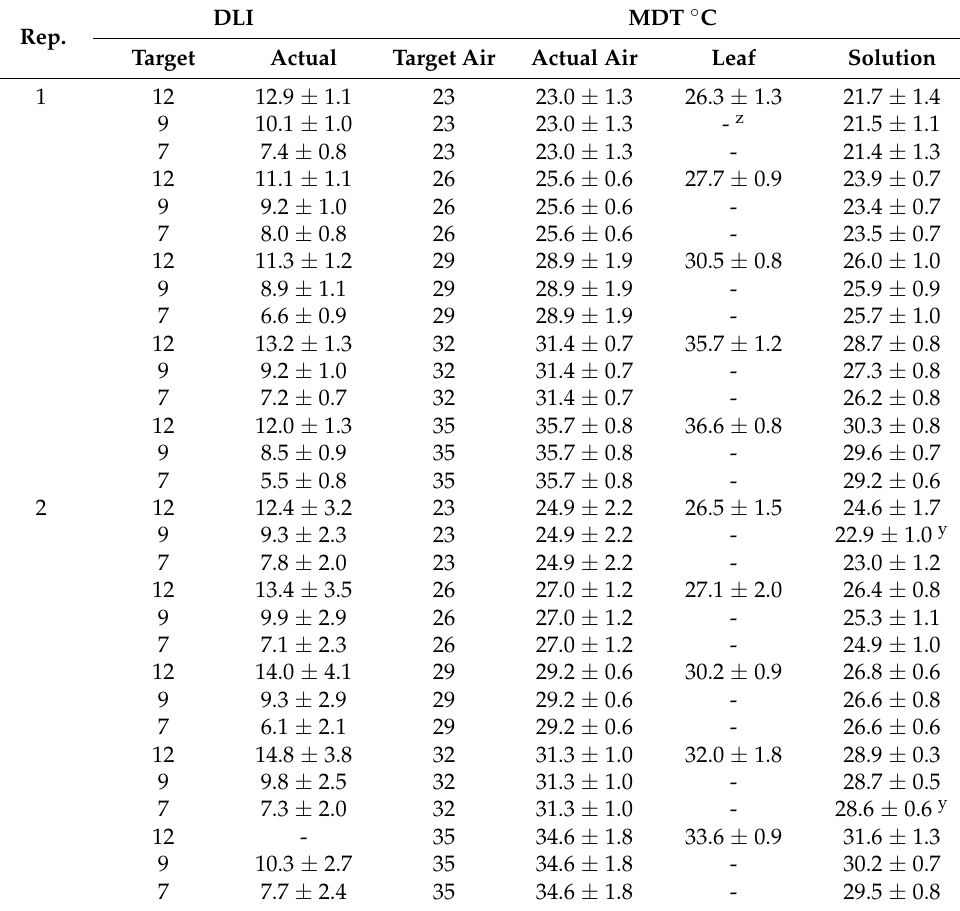
Table 1. Mean daily light integral (DLI; mol · m − 2 · d − 1 ± sd) and mean daily air temperature (MDT), leaf, and nutrient solution temperatures during the three-week growing period for sweet basil ( Ocimum basilicum ‘Nufar’) with two replications in over time. Data were collected every 15 s with means logged every